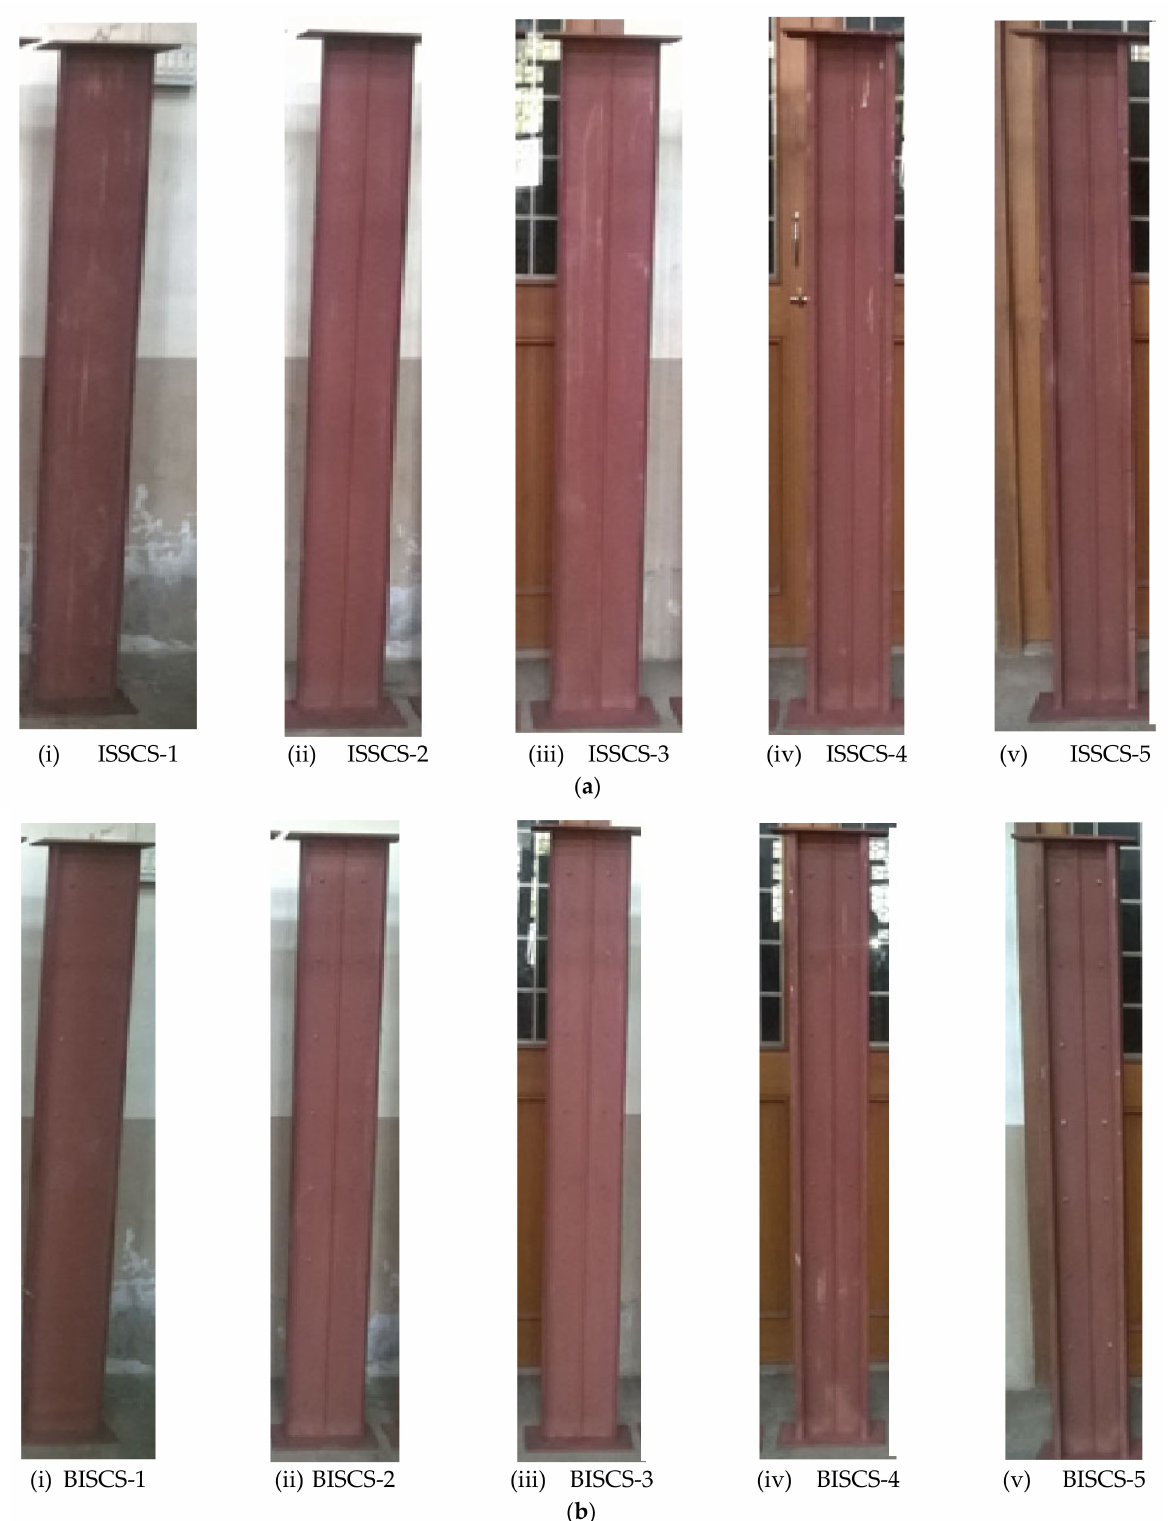
Figure 7. Specimens for experimentation. ( a ) Single Sections. ( b ) Double